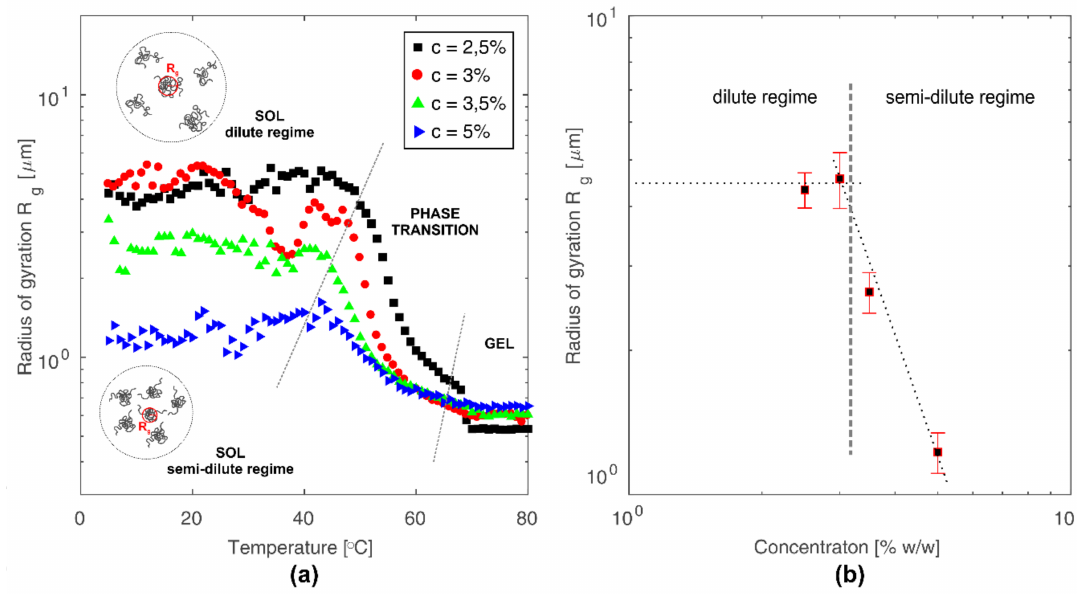
Figure 8. ( a ) Changes in the radius of gyration as a function of temperature for all tested concentrations of colloidal chitosan solutions. ( b ) Changes in the radius of gyration expressed as an average value of gyration radii at the initial phase of the process (sol) as a function of concentrations of colloidal chitosan